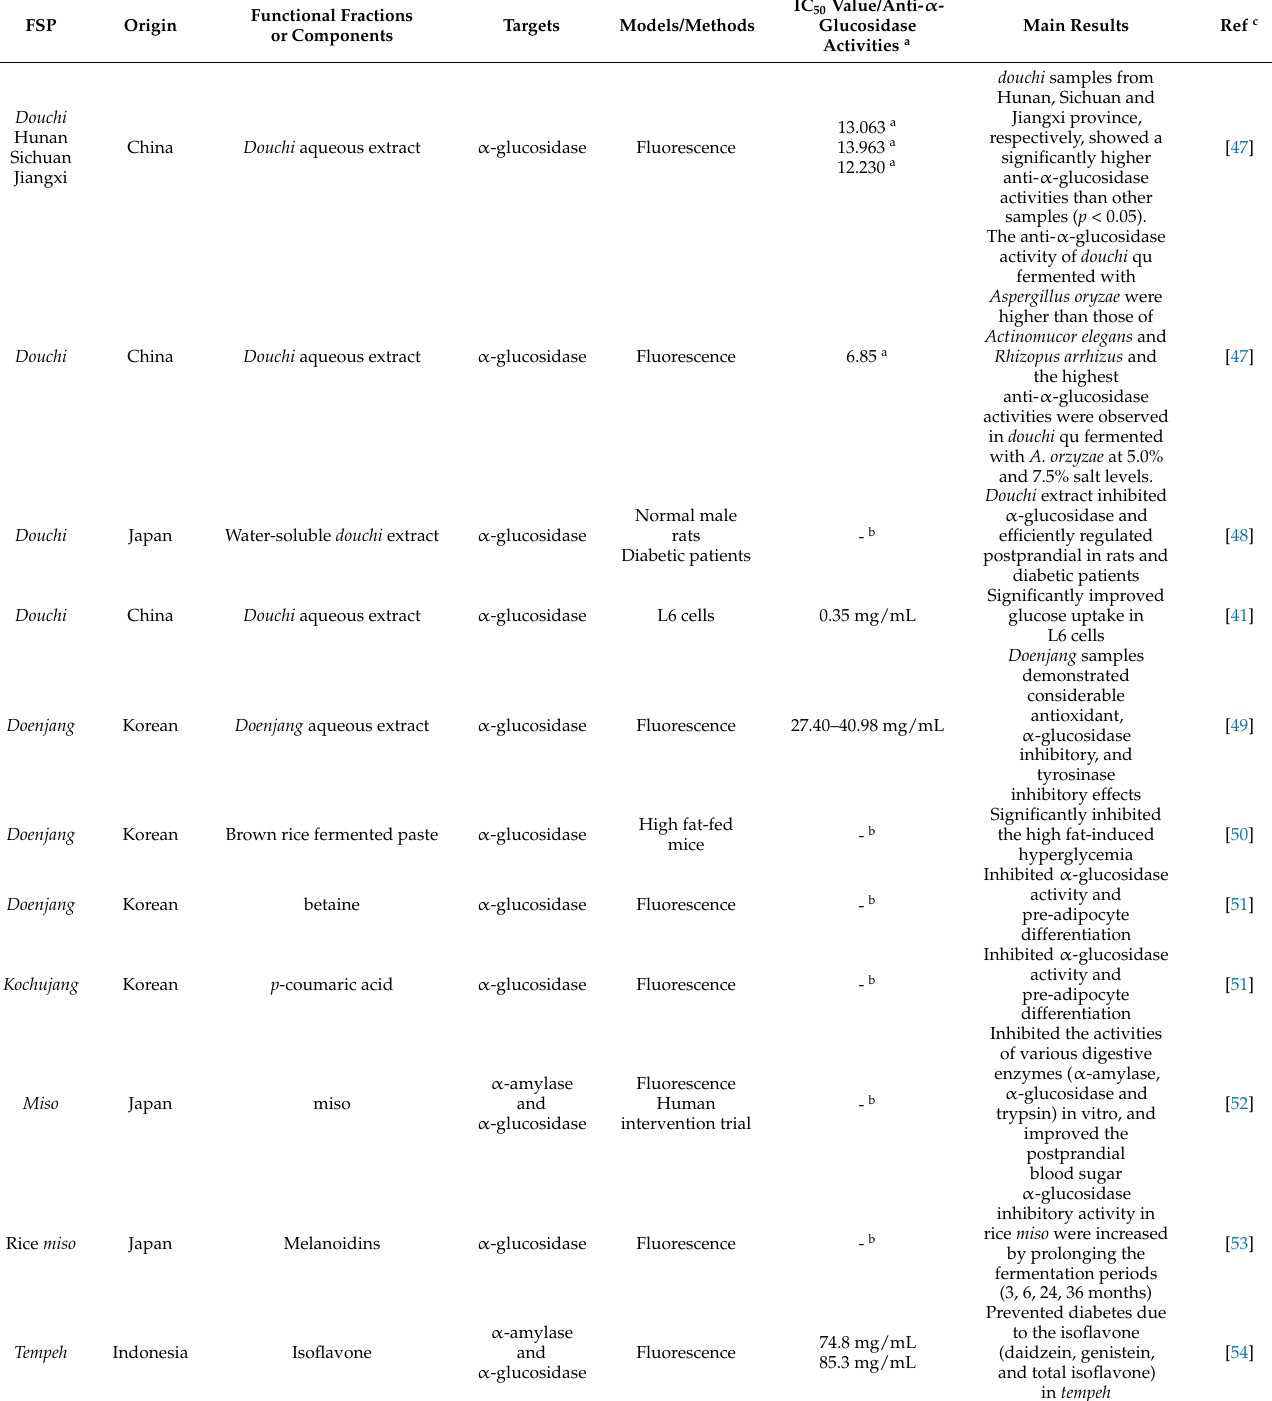
Table 1. FSP inhibit carbohydrates digestive